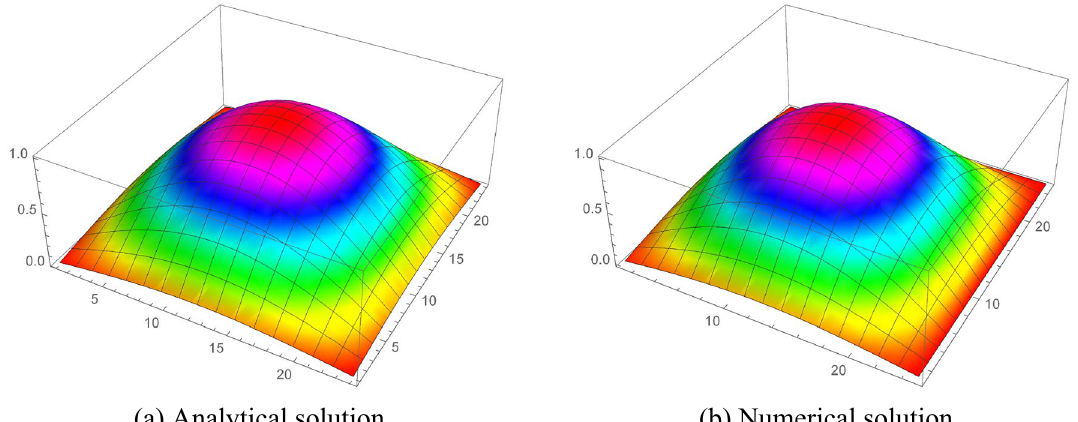
Figure 5. Analytical and numerical solution for example 1, when h = τ = 1 25 .